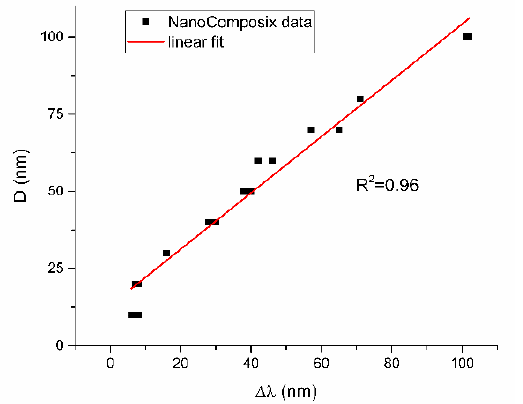
Figure 3. Dependence of mode diameter values obtained by TEM imaging for NanoComposix data on the shift of experimental to theoretical SPR wavelength.